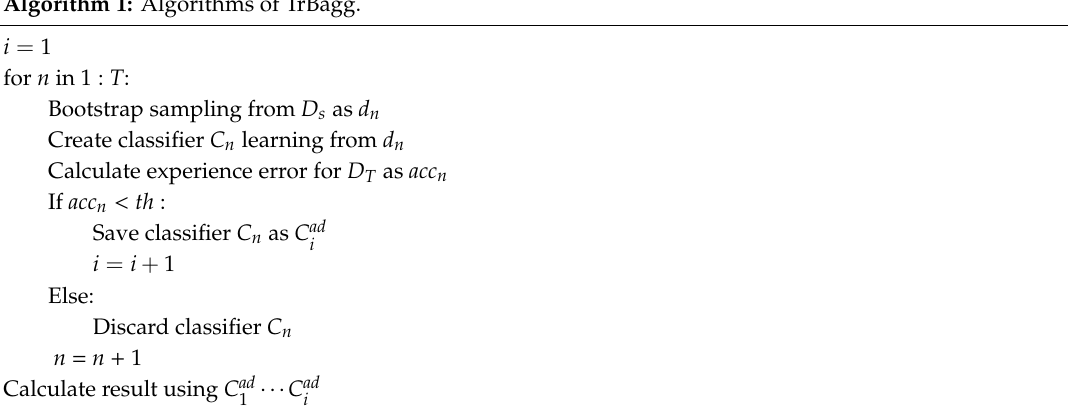
Algorithm 1: Algorithms of